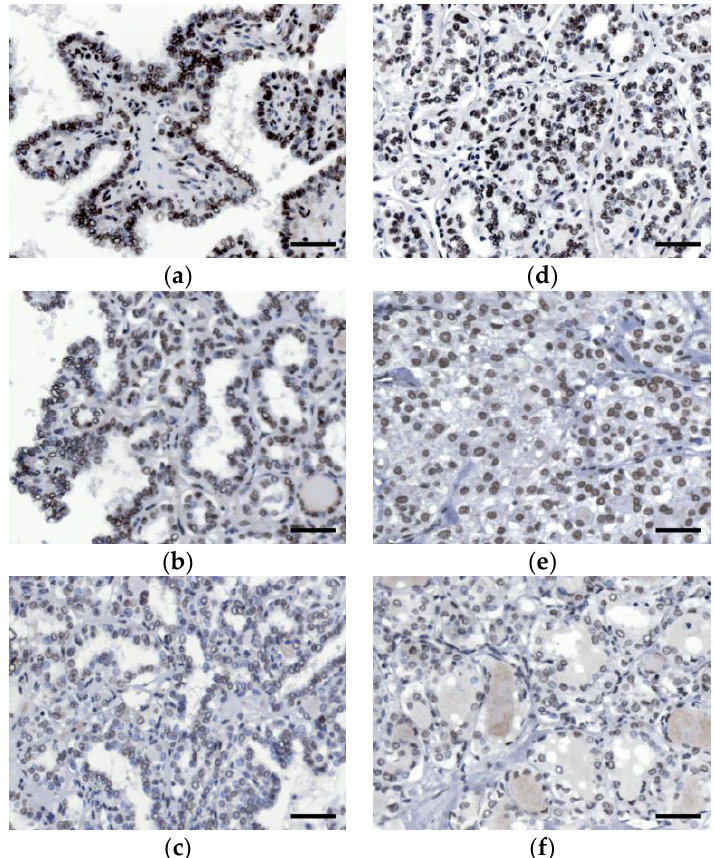
Figure 3. Immunohistochemical expression of integrase interactor 1 (INI1) in ( a – c ) papillary thyroid cancer and ( d – f ) follicular thyroid cancer. Representative microphotographs of ( a,d ) strong, ( b,e ) moderate, and ( c,f ) weak nuclear expression are shown. Scale bars: 50 μm.